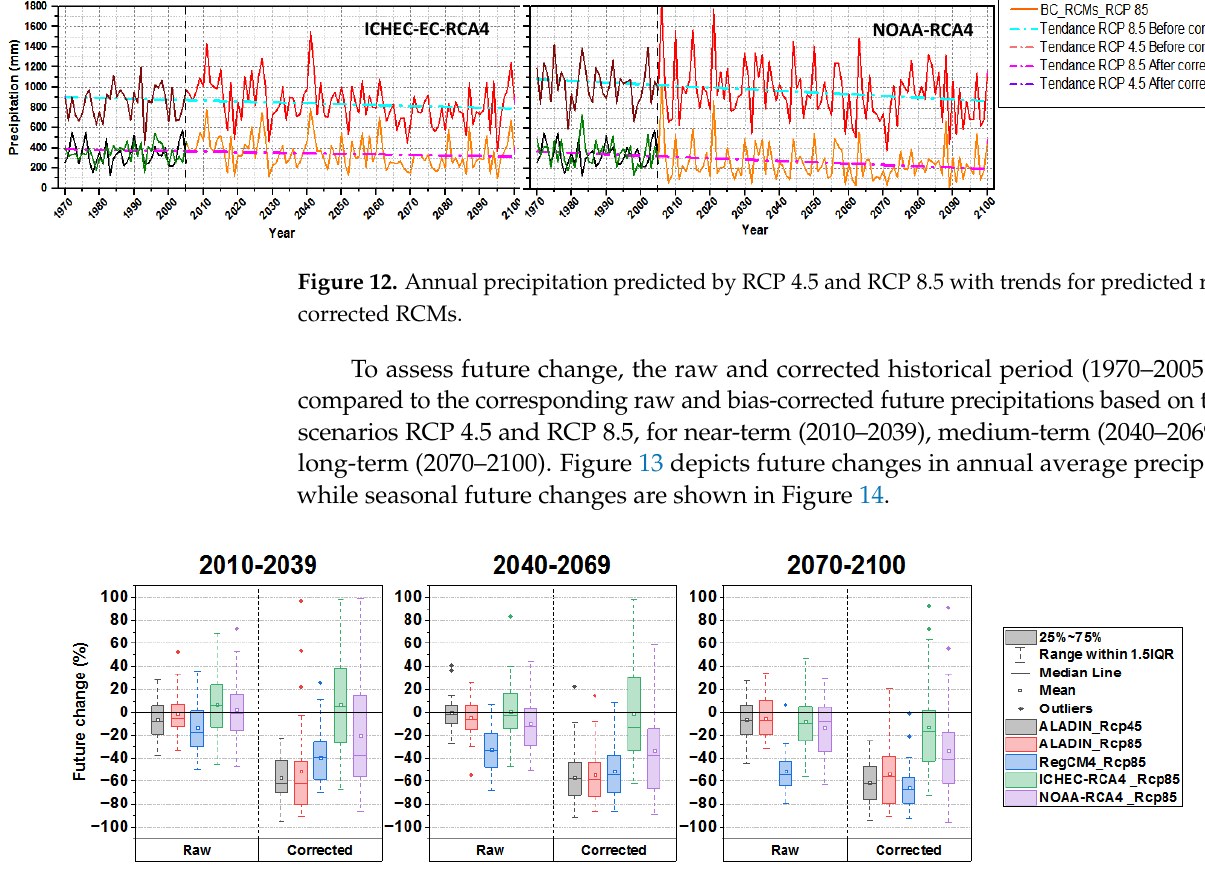
Figure 13. Relative changes of annual average precipitation for 2010 – 2039, 2040 – 2069, and 2070 – 2100 (2070 –2099 for RegCM4) with respect to 1970‒2005. Changes are given in %.